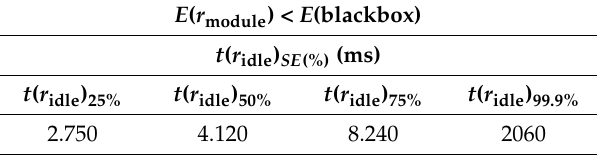
Table 3. The energy efficiency conditions when reconfiguration process does not nullify the energy savings that would be achieved with the reconfiguration. The value t ( r idle ) minimum time required by the black box to save a quantity of energy equal to the saving factor in percentage.